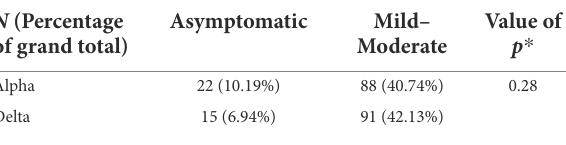
TABLE 4 Contingency table of SARS-CoV-2 variant vs. symptoms.